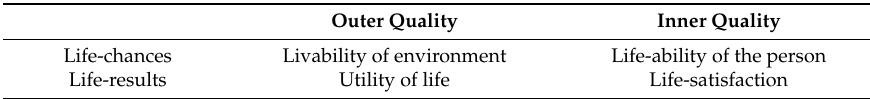
Table 1. The four qualities of